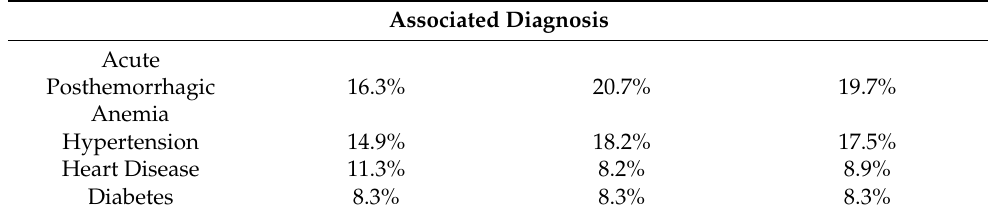
Table 4. Diagnosis associated with proximal femoral